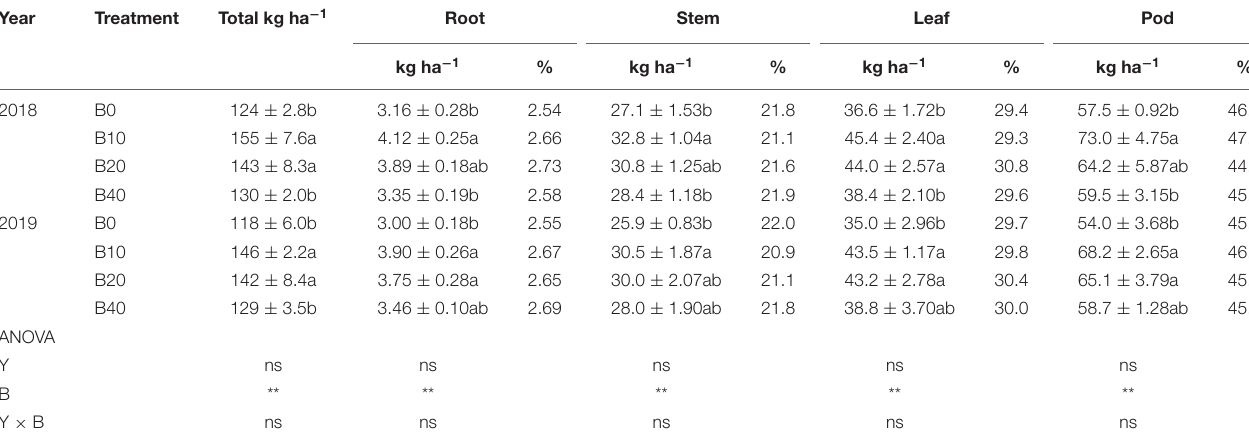
TABLE 3 | Nitrogen accumulation and distribution at the pod set in peanut with four rates of biochar in the 2018 and 2019 growing seasons. Year Treatment Total kg ha − 1